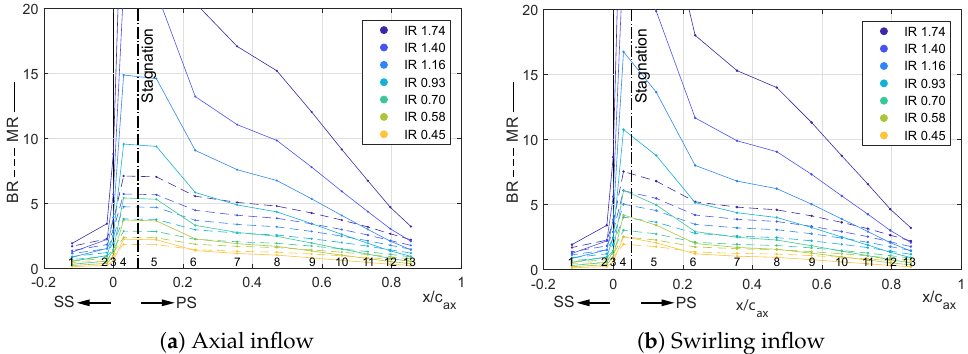
Figure 8. Blowing ratio BR (dashed lines) and momentum flux ratio MR (solid lines) for different injection ratios IR (in %) at each coolant hole (1 to 13).